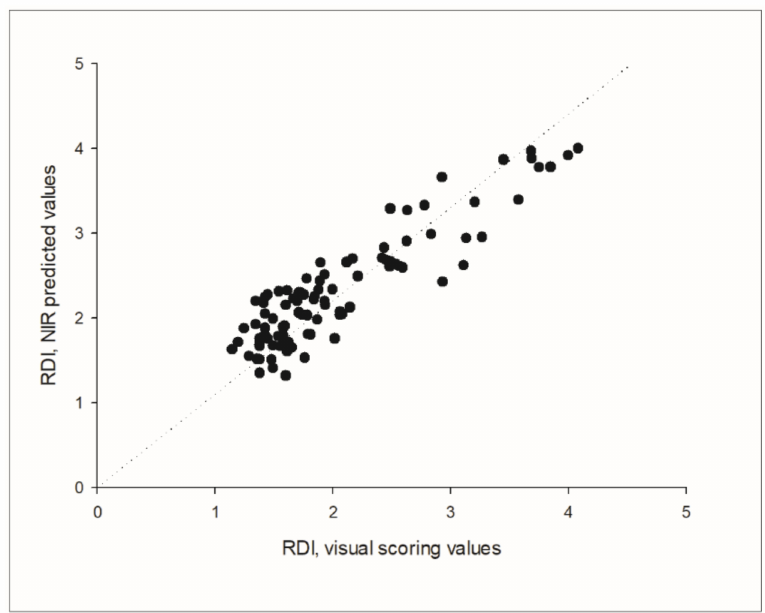
Figure 7. Prediction of an external independent data set obtained from a field with natural Rhizocto- nia contamination from harvest season 2021 in Germany ( n = 94; R =